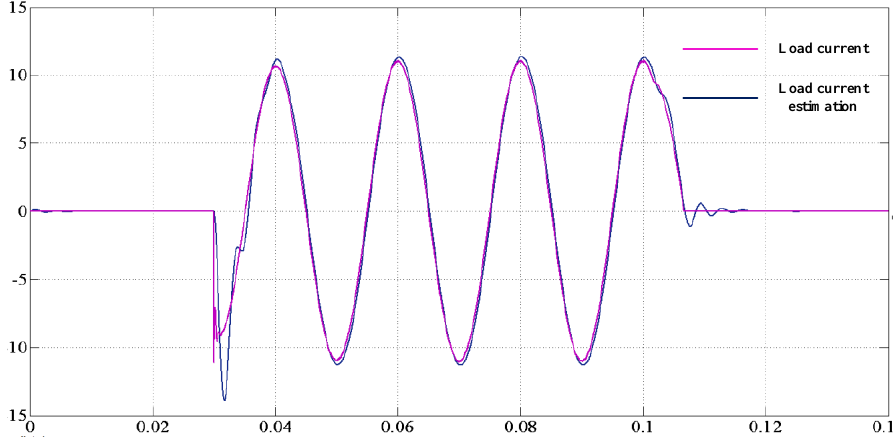
Figure 6. Typical performance of the designed